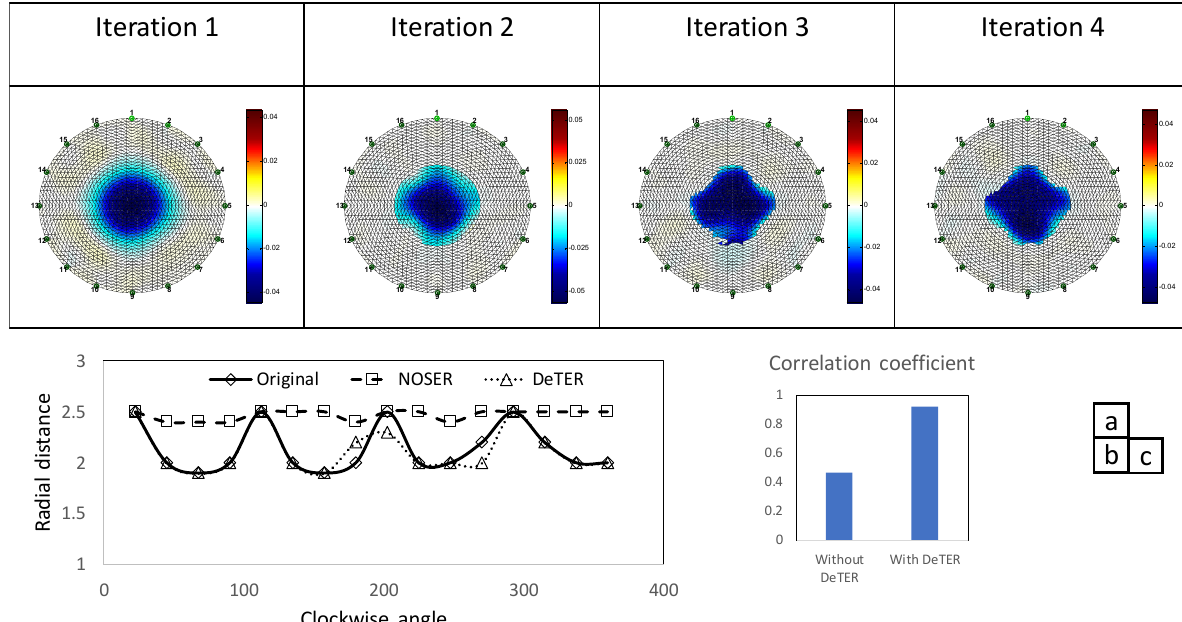
Fig.9: (a) Reconstruction of diamond shape object with DeTER using NOSER prior (b)Shape descriptor for original and reconstructed images with and without DeTER (c) Comparison of correlation coefficients.